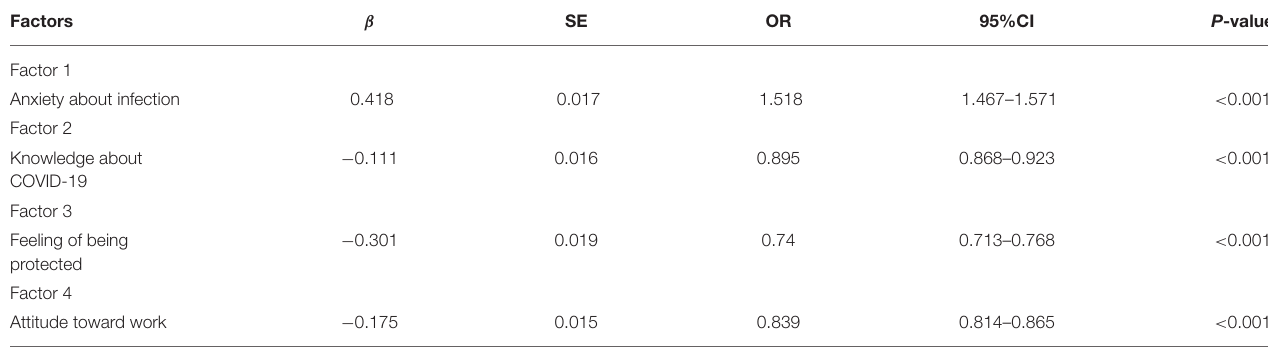
TABLE 4 | Binary logistic analysis of the four factors with a positive GHQ-12.